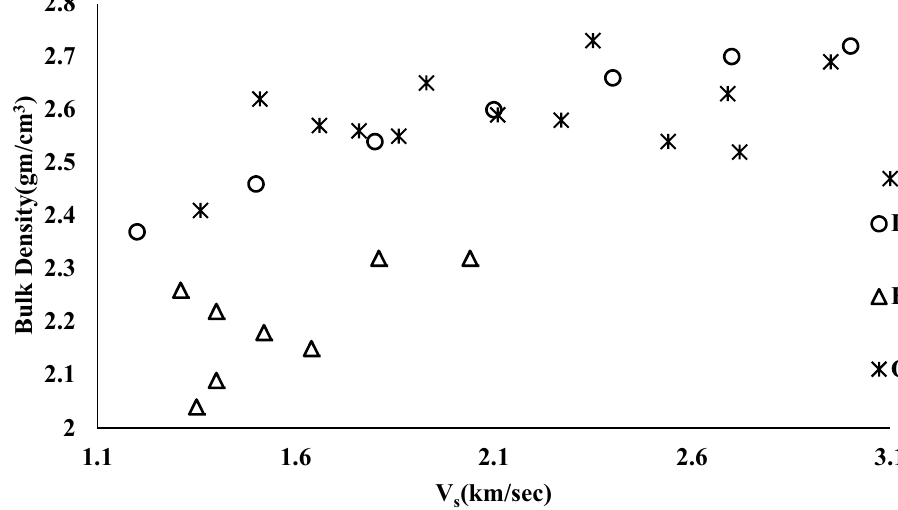
Fig. 6 V s (shear wave velocity) versus bulk density as reported by different